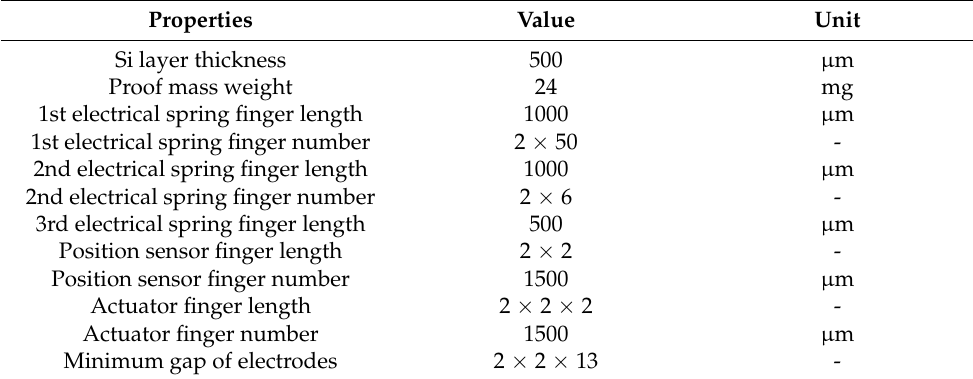
Figure 4. ( a ) Schematic of seismometer structure. ( b ) Top view of the seismometer layout used in a FEM simulator MEMS +. Table 2. Dimensions of the seismometer.